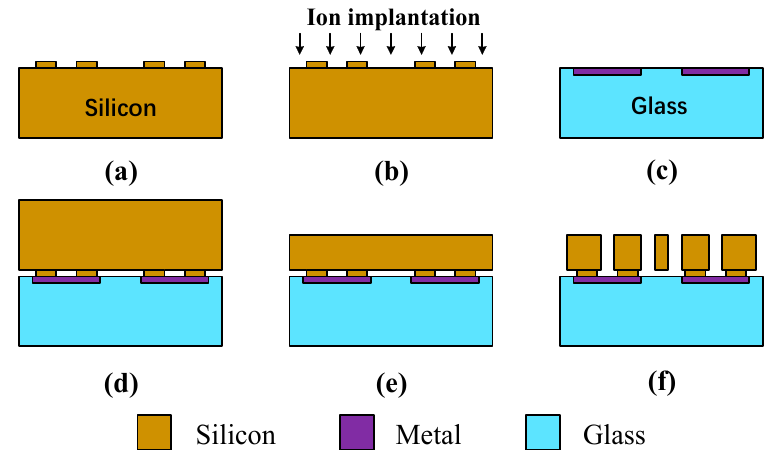
Figure 7. The standard SOG process. ( a ) Etch bonding area on silicon wafer. ( b ) Ion implantation on